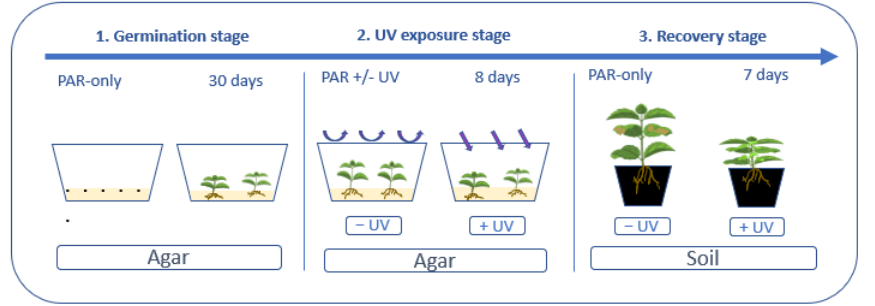
Figure 1. A schematic of the experimental design. Plants were grown for 30 days under PAR light (germination stage), then the lid was replaced with either Mylar or CA and exposed to UV and PAR for 8 days (UV exposure stage) and finally transplanted on soil for 7 days under PAR light (recovery stage). Measurements were taken in between each step.